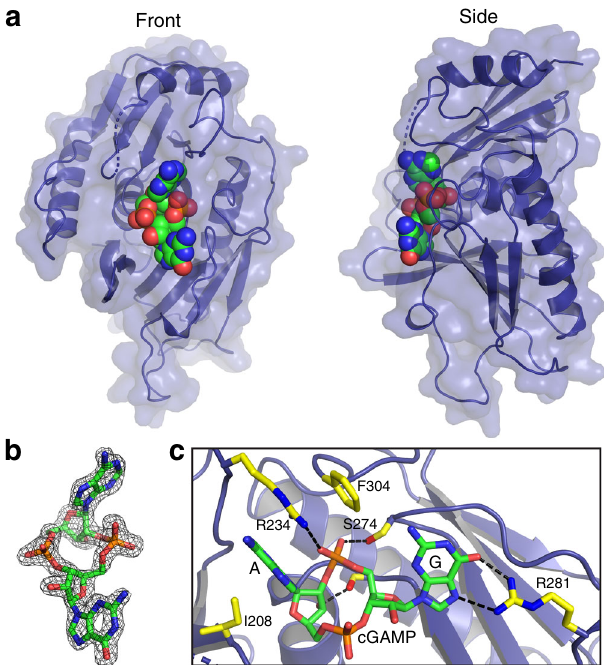
Fig. 4 Molecular recognition of 3 ′ ,2 ′ -cGAMP by Cap5-SAVED. a Crystal structure of Ll Cap5 - SAVED in complex with 3 ′ ,2 ′ -cGAMP. Ll Cap5 - SAVED is in cartoon and surface, and 3 ′ ,2 ′ -cGAMP is in the sphere and colored individually, with carbon in green, oxygen in red, nitrogen in blue, and phosphate in orange. b Simulated-annealing F o − F c omit map (contoured at 2 σ ) of the ligand density, demonstrating unambiguous assignment of the second messenger as 3 ′ ,2 ′ -cGAMP. c Detailed interactions between 3 ′ ,2 ′ - cGAMP and residues from Ll Cap5 - SAVED. The side chains of Ll Cap5 - SAVED are in stick and colored individually, with carbon in yellow, oxygen in red, and nitrogen in blue. Hydrogen bonds between 3 ′ ,2 ′ -cGAMP and Ll Cap5 - SAVED are highlighted in black dashed